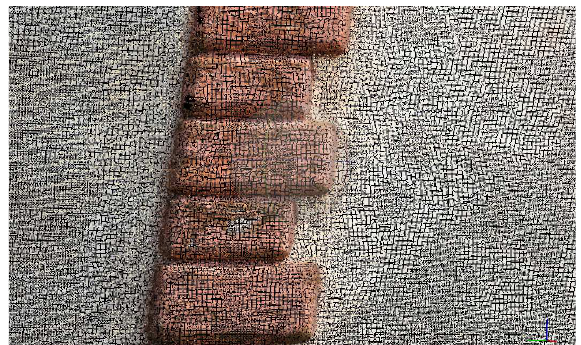
Figure 13. Enlarge view of the detail in figure 12.